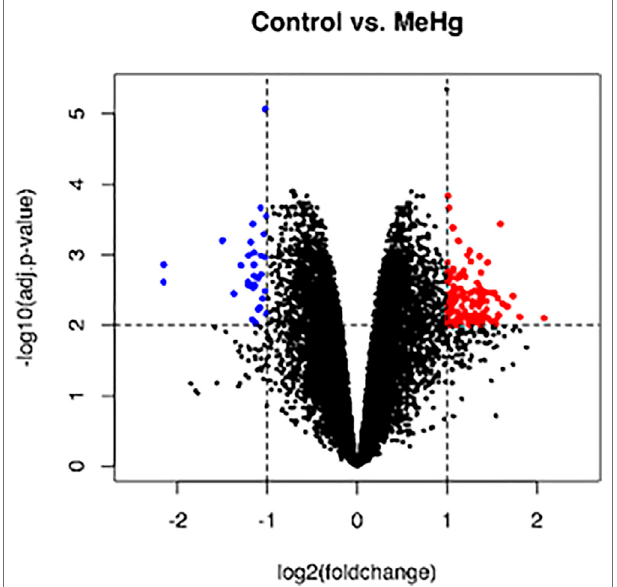
FIGURE 3 | Differentially expressed genes in exposed human salivary gland cells line to 2.5 µM of MeHg vs. nonexposed cells (MeHg vs. Control) is demonstratedthroughtheheatmap.Thedendrogramsrepresenthierarchical cluster relationship between genes (left side) and among samples (upper), based on Pearson ’ s correlation; log2FC > 1 or < − 1. log2fold change > 1.5 or < − 1.5; adj.; cutoff adj. p -value: < 0.01.